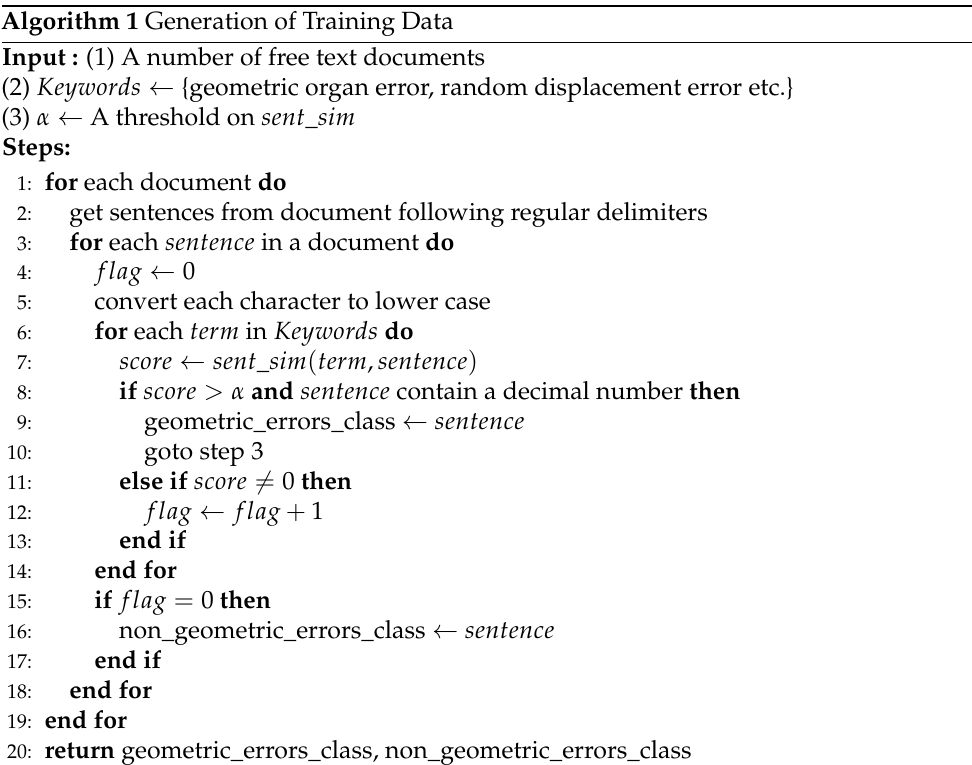
Algorithm 1 Generation of Training